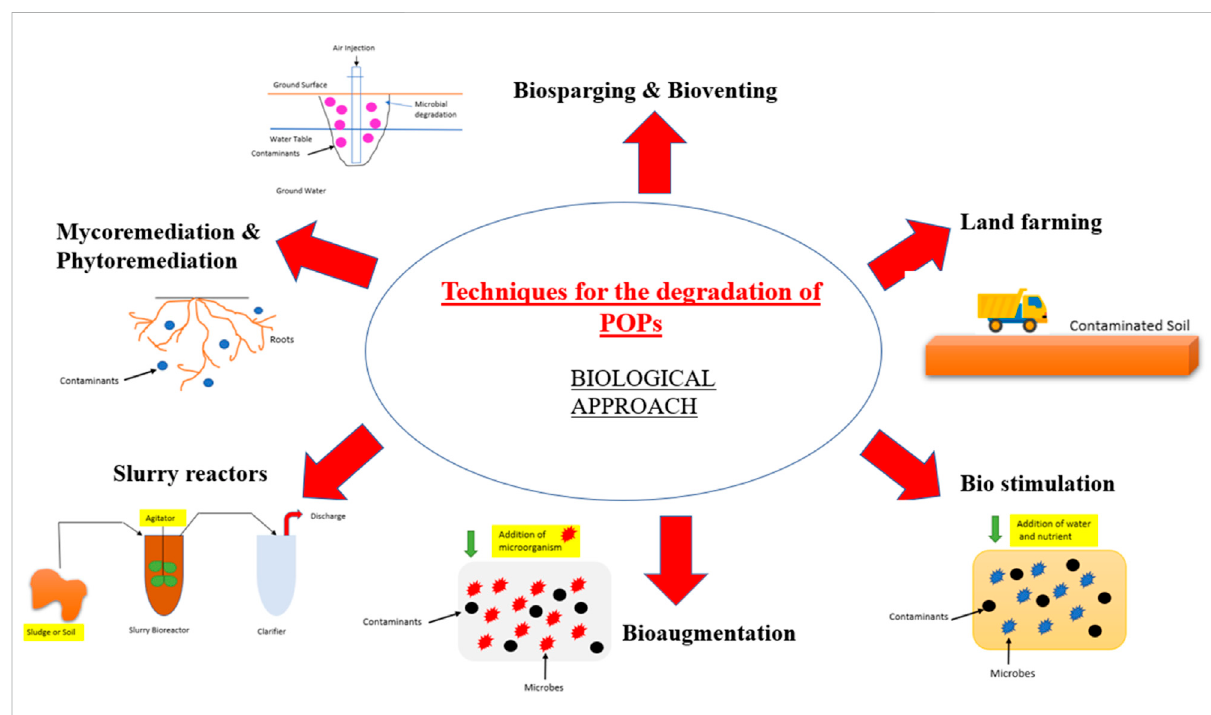
FIGURE 3 Biological techniques used for the degradation of persistent organic